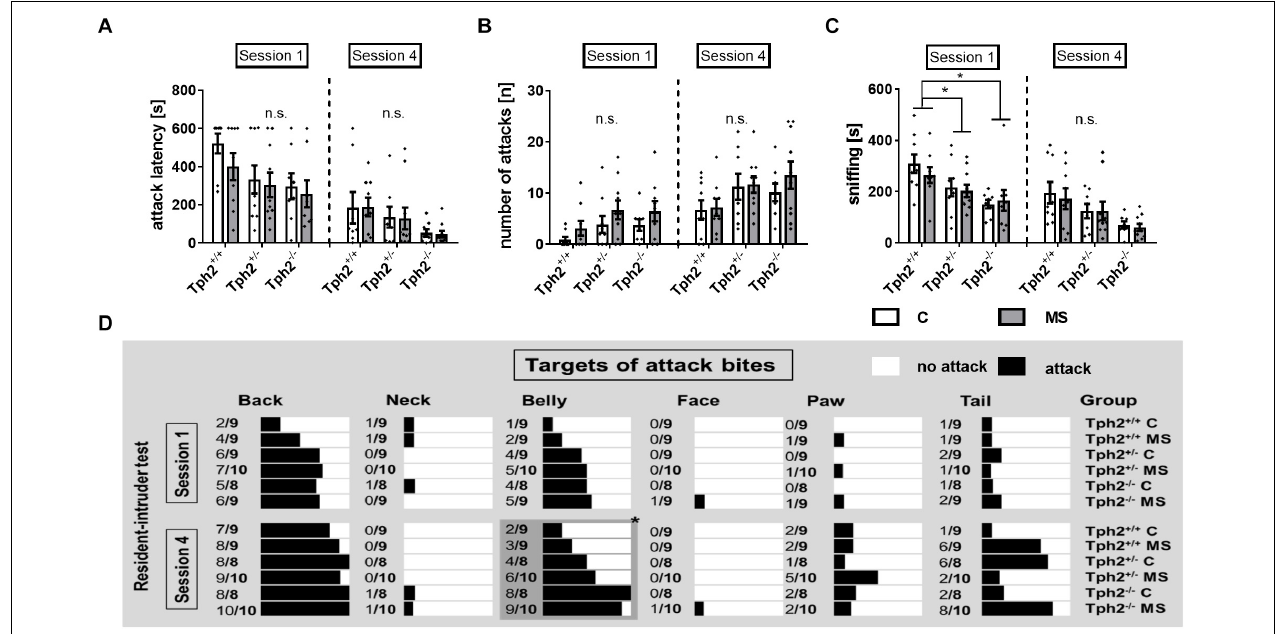
FIGURE 3 | Social behaviors determined using repeated resident-intruder test (RIT). (A) Latency to attack [s] as well as (B) number of attacks [n] were not affected by the animals’ tryptophan hydroxylase 2 ( Tph2 ) genotype, exposure to maternal separation (MS) or Tph2 ∗ MS interaction during the first and fourth session of the RIT. (C) Sniffing [s] during the first session was decreased in mice carrying homo- and heterozygous genetic tryptophan hydroxylase 2 (TPH2) inactivation in both animals of the control (C) and MS condition. (D) During the fourth session targets of attack bites [nominal] of Tph2 − / − males were directed more toward vulnerable body parts, i.e., the belly, when compared to Tph2 + / − and Tph2 + / + males. (A–C) Bars represent group means ± standard errors ( n /group = 8–10). ∗ FDR-corrected p < 0.050 ( Post hoc : Mann-Whitney U). (D) The relative number of animals per group by attack targets such as back and belly. The black bars represent the % of animals attacking the indicated target. ∗ FDR-corrected p < 0.050 (Pearson chi-square test of categorical data, attack vs. no attack, n/group =